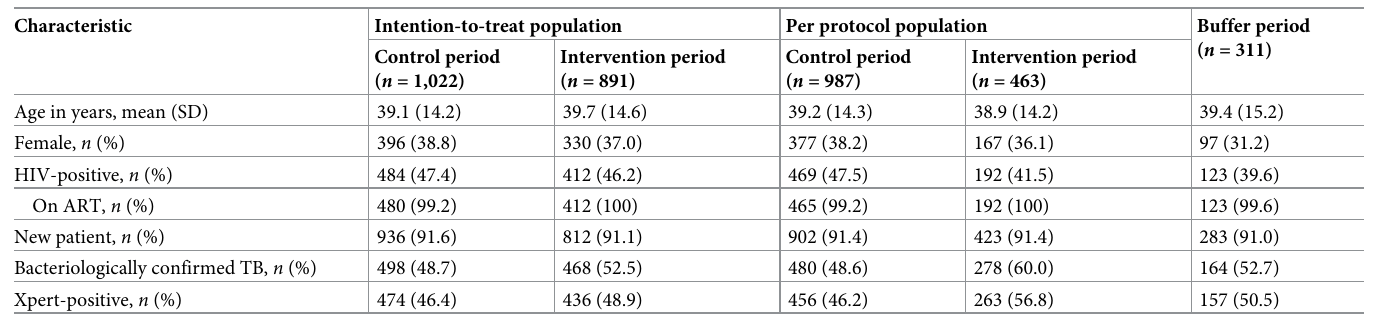
Table 1. Participant baseline characteristics by study population and